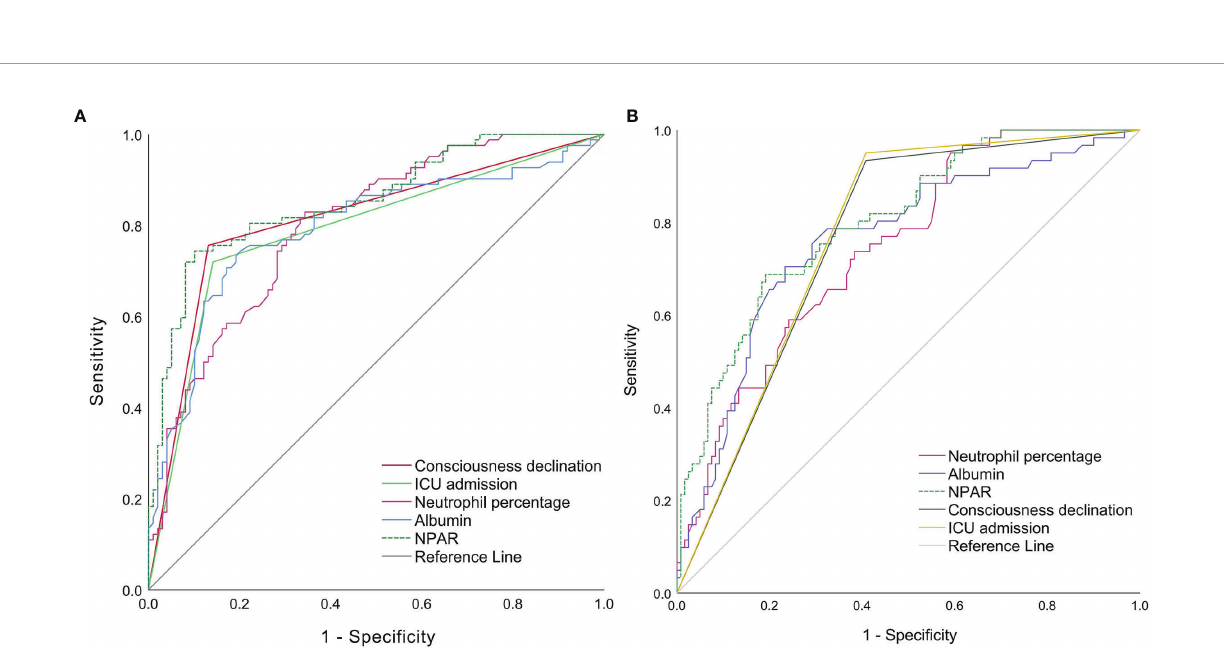
FIGURE 6 | ROC curves of individual factors in assessing severity at admission (A) and predicting short-term prognosis (B) ICU, intense care unit; NPAR, neutrophil percentage-to-albumin ratio.